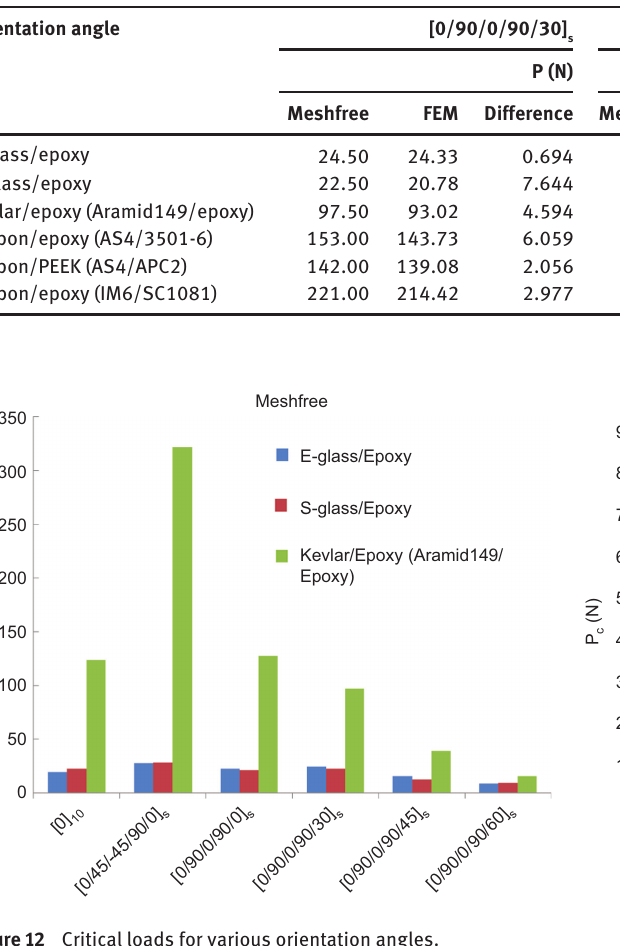
Figure 13 Critical loads for various orientation angles